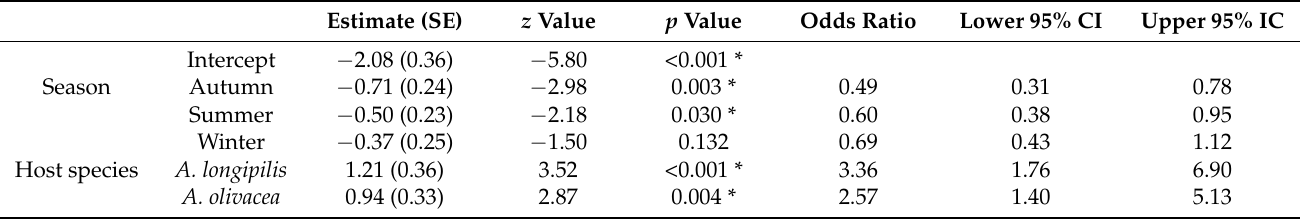
Table 4. Results of the best generalized linear model (GLM) that predicted the probability of positivity for helminths in rodents. Spring and O. longicaudatus were used as the reference categories. Hosmer–Lemeshow test: χ 2 = 10.96, p = 0.20 ( p > 0.05 is interpreted as fit).